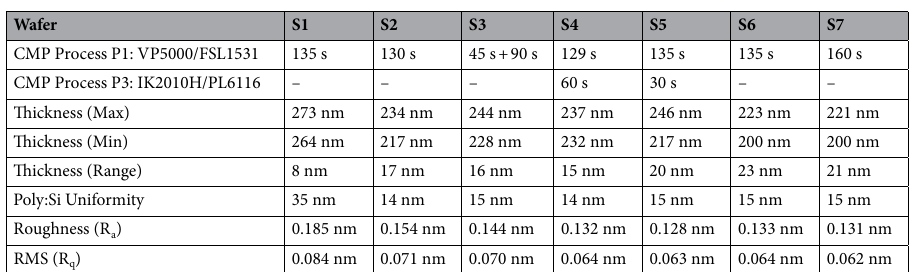
Table 1. CMP process times and final poly:Si surface properties. S1, S2, S3, S4, S5, S6 and S7 represent the seven different wafers processed with the different CMP regimes.